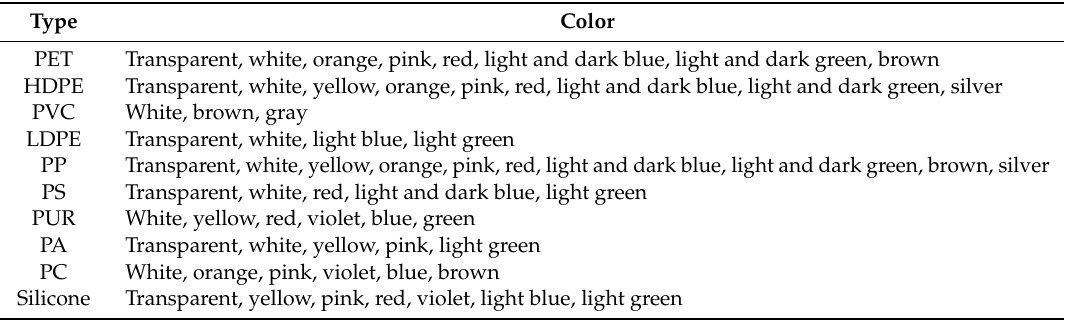
Table 3. Types and colors of household plastic samples tested by MicroNIR and used for the library. Type Color PET Transparent, white, orange, pink, red, light and dark blue, light and dark green, brown HDPE Transparent, white, yellow, orange, pink, red, light and dark blue, light and dark green, silver PVC White, brown, gray LDPE Transparent, white, light blue, light green PP PS